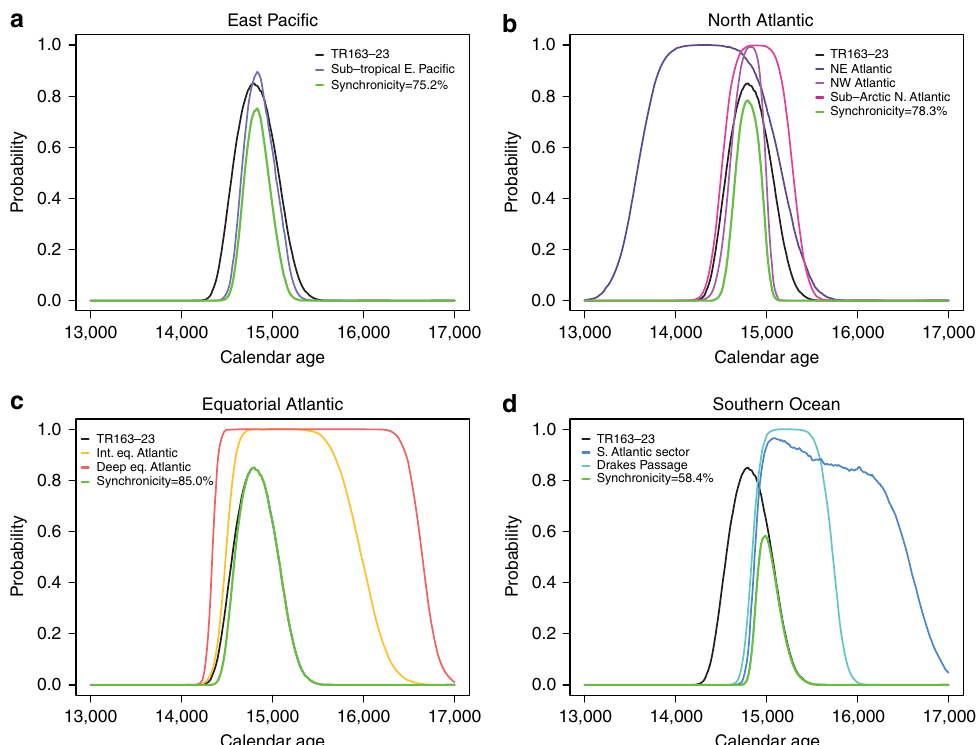
Figure 8 | Inter-ocean synchronicity of the 14.8ka ventilation event. The Bayesian age modelling program BACON 44 was used to resample reported chronologies along a uniform time interval and to calculate the probability of the 14.8ka ventilation event occurring at each study site from 13.0–17.0ka using a 100-year window with a 10-year time step 55 . Incorporating age uncertainties, event probabilities were combined to test for synchronicity. The width of an individual probability curve is determined both by event length and age model uncertainty whereas the height is a function of age model certainty alone; for example, a narrow curve with peak probability close to 1.0 corresponds to a brief, well-defined event. Our EEP record is synchronous with the other ( a ) East Pacific (72.3%), and ( b ) North Atlantic (78.0%) records within 1 s (68.27%). ( c ) The 14.8ka event in equatorial Atlantic records ends at a similar time as the EEP; however, this region has insufficient resolution at the onset of this event to determine whether the 14.8ka event was indeed simultaneous with the EEP. ( d ) Southern Ocean records suggest an earlier ventilation event with less likelihood of synchronicity (48.7%) at